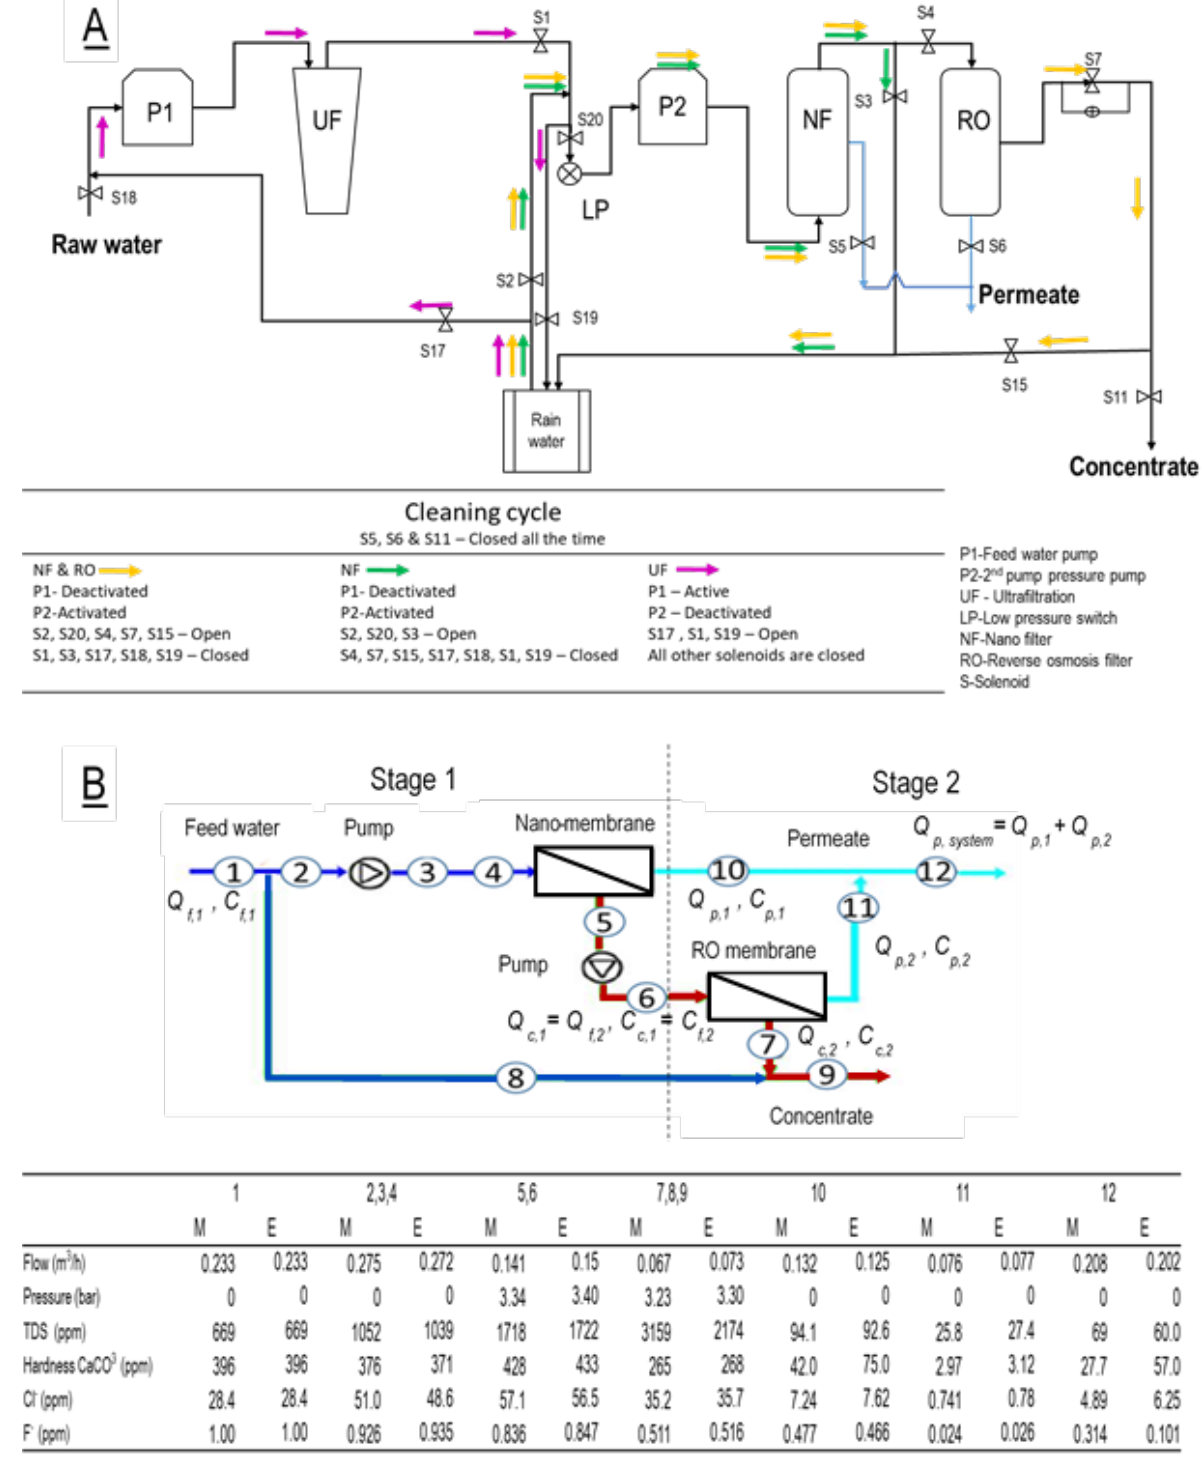
Figure 4: A. Schematics of water treatment plant B. Topological configuration of membrane network. Modelled water quality data are also shown. M. modelled data, E: experimental